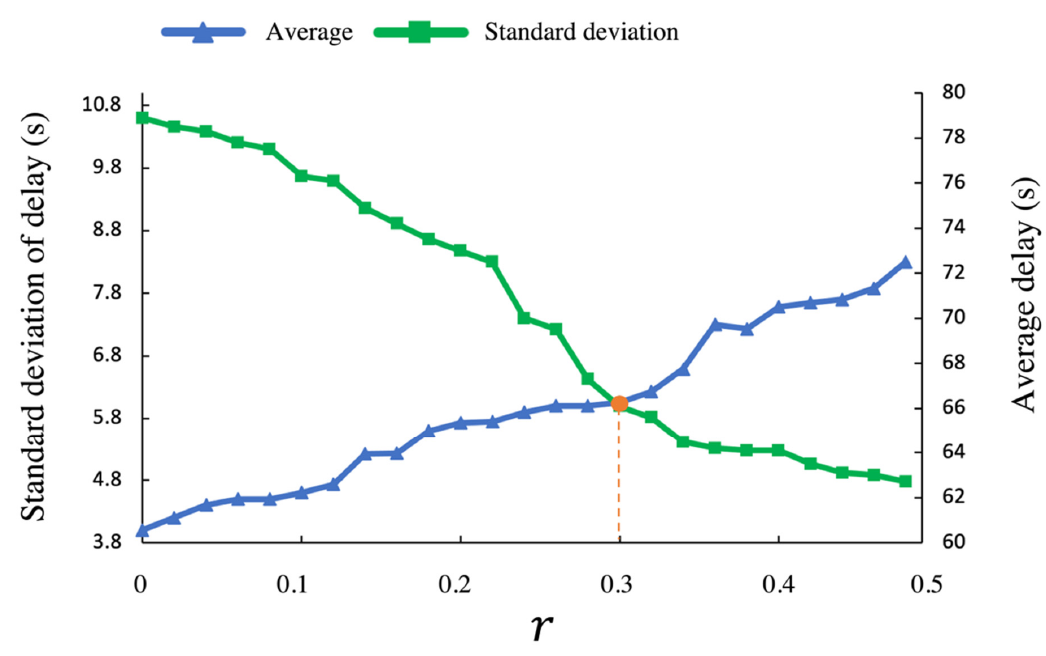
Figure 14. Effect of efficiency stability coefficient on delay.